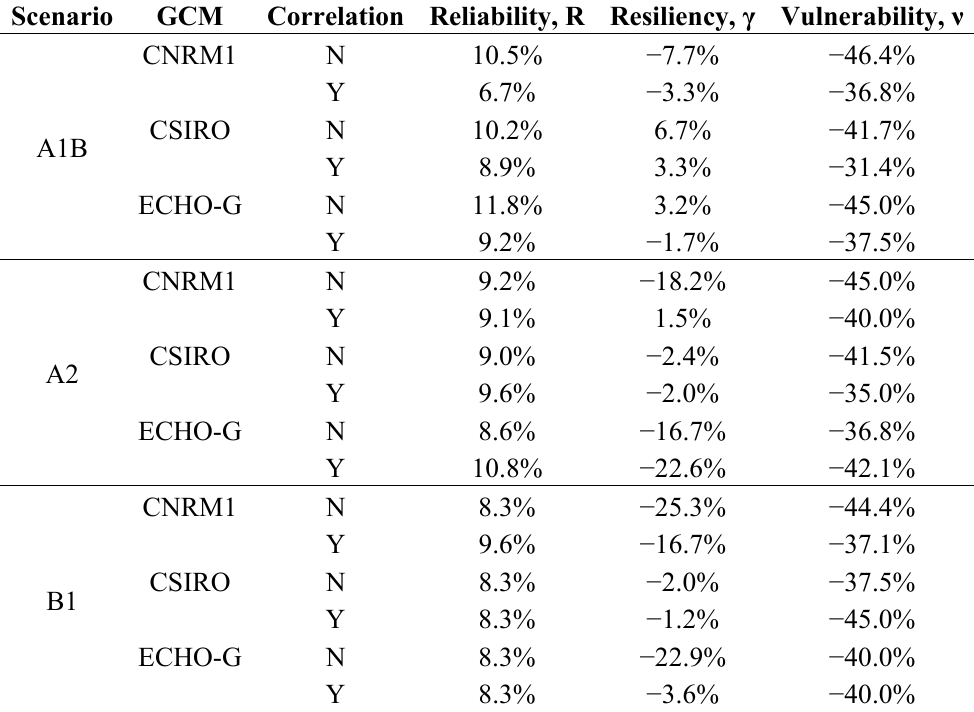
Table 7. Percentage changes in the performance criteria for the test catchment 1001 (2070–2099) for a storage size of 20 cm/m 2 and N c = 3, depending on GCMs and climate change